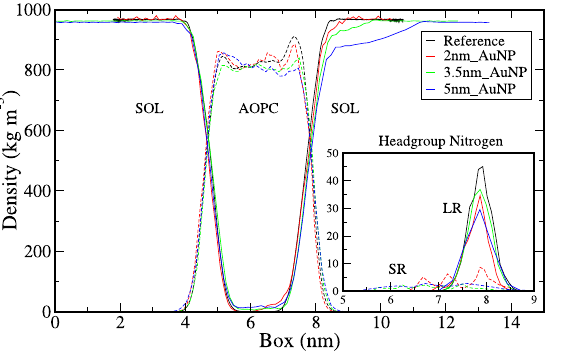
Figure 2. Partial densities of water and AOPC. Dotted lines represents lipid and solid lines represents the water partial densities. Black, red, blue and green lines represent reference, 2 nm_AuNP, 3.5 nm_AuNP and 5 nm_AuNP systems respectively. Figure Inset represents partial densities of head–group Nitrogen atoms of SR and LR lipid of interacting lipid monolayer where dotted lines shows SR lipids and solid lines shows LR